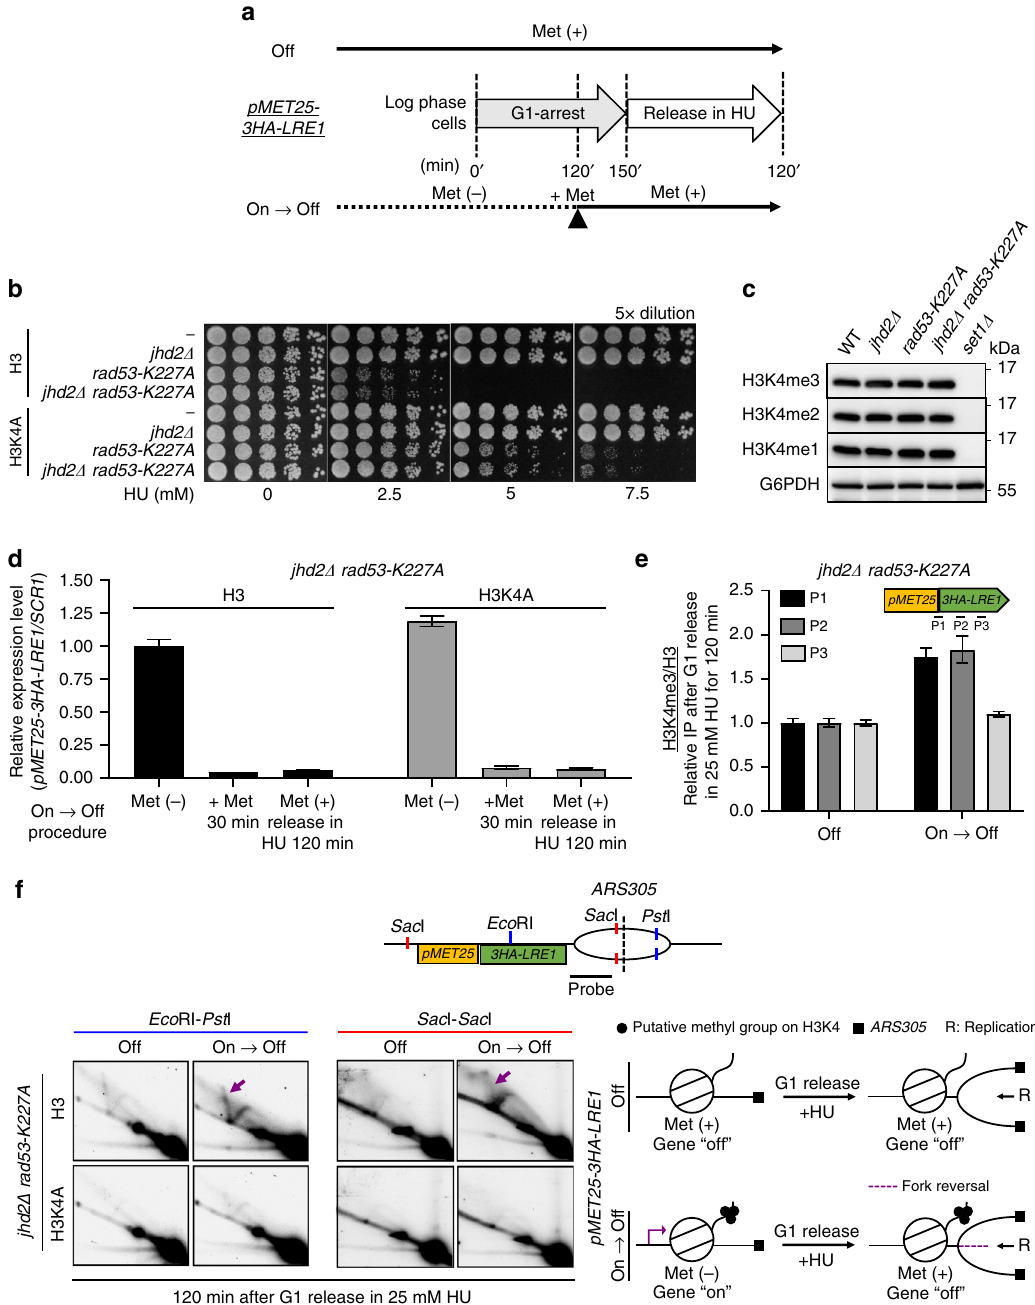
Fig. 5 H3K4 methylation promotes defective replication fork formation in rad53 mutants. a A schematic representation of the experimental procedure to examine the effect of H3K4me on HU-treated rad53 mutants. b HU sensitivity was determined for JHD2 and jhd2 Δ mutants on the RAD53 or rad53-K227A backgrounds with wild-type H3 or H3K4A mutation. c Immunoblot showing H3K4me1/2/3 levels in jhd2 Δ strains. d Normalized pMET25-3HA-LRE1 expression in jhd2 Δ rad53-K227A with wild-type H3 or H3K4A mutation e H3K4me3 deposition on indicated regions of pMET25-3HA-LRE1 in in jhd2 Δ rad53-K227A with wild-type H3 after following the procedure show in a ; all error bars represent±SEM ( n = 3 technical replicates). f 2D gel analysis of Eco RI- Pst I-digested and Sac I- Sac I-digested fragments of the ARS305 region in jhd2 Δ rad53-K227A with wild-type H3 or H3K4A mutated cells. In brief, cells were G1-released in 25mM HU with suppressed pMET25-3HA-LRE1 transcription but with low (Off) or high (On → Off) levels of residual H3K4me. The purple arrows indicate spike signals corresponding to aberrant DNA intermediates that accumulated in HU treated rad53-K227A mutant with high level of H3K4me